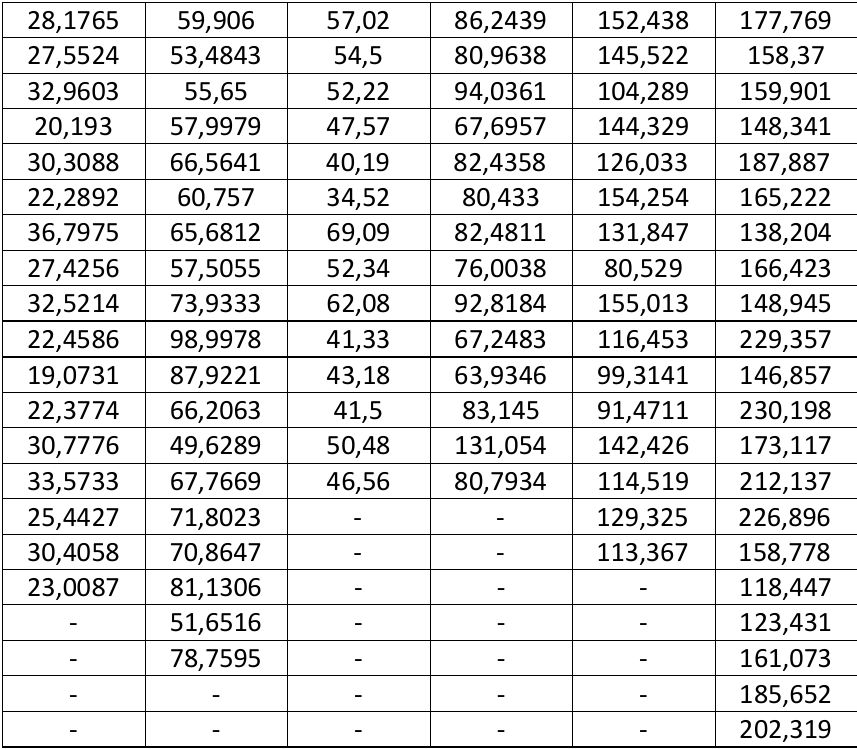
Table 1 - Lab test times for a given number of testing samples